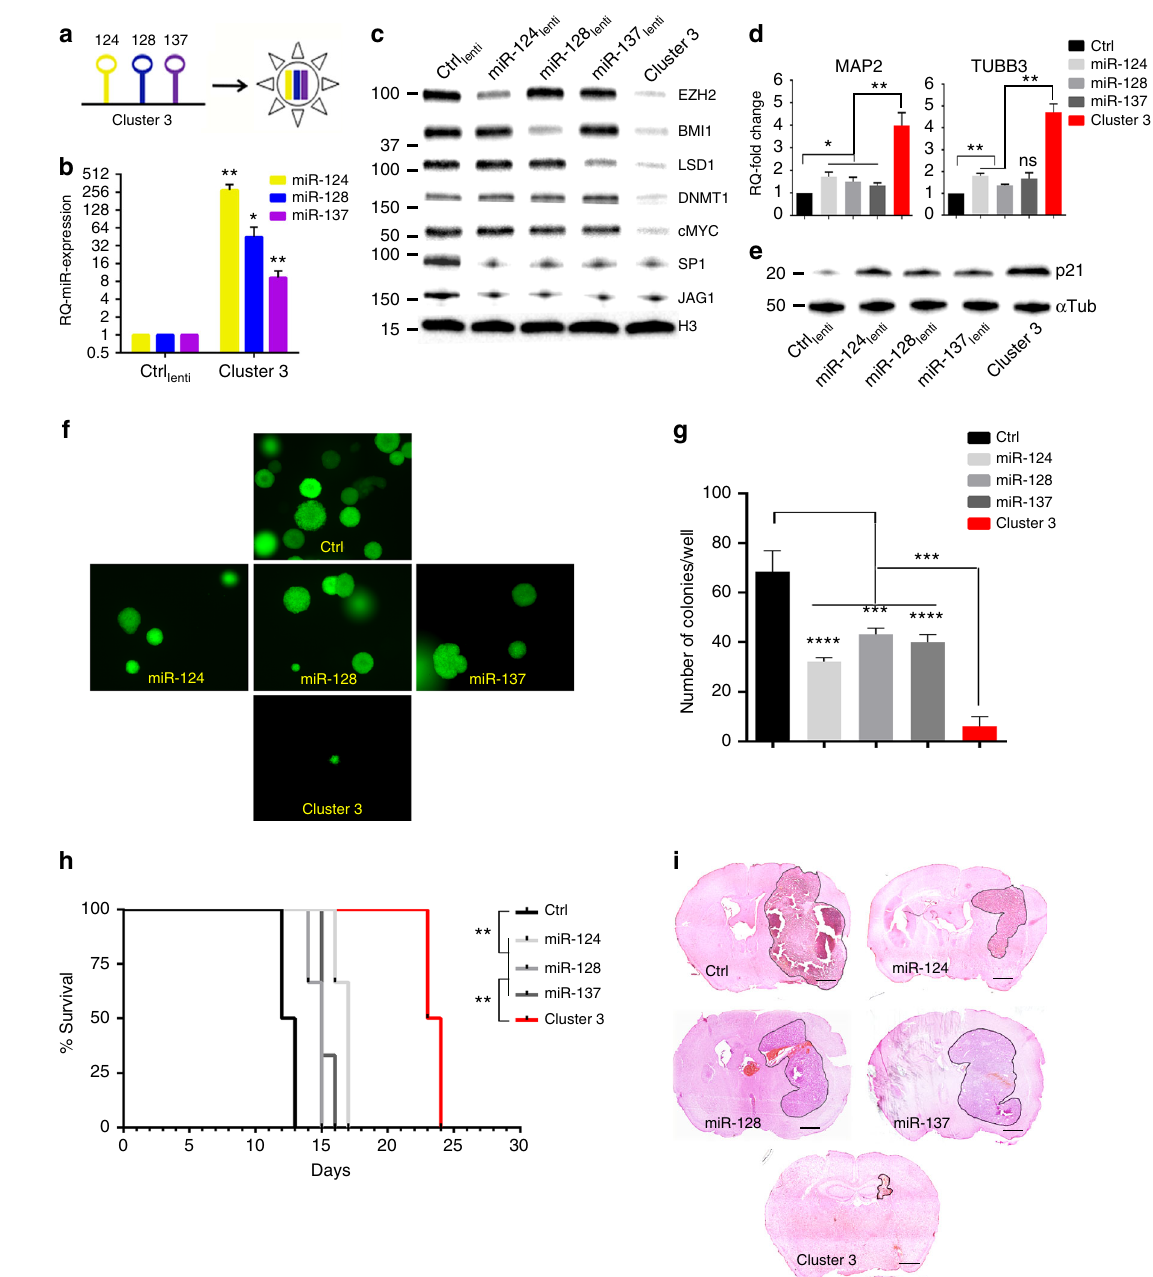
Fig. 3 Biological effects of microRNA clustering. a Cartoon depicting the engineering of Cluster 3. b Relative quanti fi cation of microRNA expression in G34 GSC transduced with Cluster 3 transgene or negative control (GFP-only transgene). c Representative Western blot from whole cell protein lysate of G34 GSC stably expressing different microRNAs. d Relative quanti fi cation of MAP2 and TUBB3 ( β 3-tubulin) gene expression by quantitative real-time PCR after microRNA overexpression. e Western blot from G34 GSC showing p21 protein level after microRNA overexpression. f Soft agar clonogenic assay. Representative images of GFP-positive G34 cells 14 days after plating into 12-well plates (1000 cells/well). Image acquired with ×4 optical lens (4 × 4 tile scanning). g Total count of colonies in e . h Kaplan − Meier survival curve of female athymic nu/nu mice intracranially implanted with 10,000 G34 GSC stably expressing the indicated microRNAs (or negative control GFP). Six mice/group. Log Rank test, corrected by Bonferroni analysis. ** p < 0.001. i Representative hematoxylin and eosin stain of paraformaldehyde- fi xed brains from mice in c . All brains were collected at day 12 post-tumor implantation. Scale bars: 1 mm. For all bar graphs, means ± SD from three independent experiments are reported. * p < 0.05; ** p < 0.01; *** p < 0.001; **** p < 0.0001 (Student ’ s t test, two tails, multiple comparisons). GSC glioblastoma stem-like